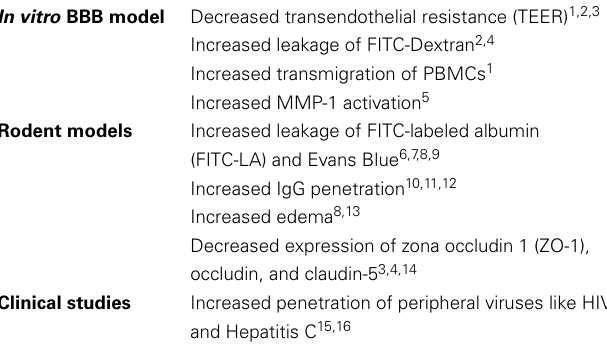
Table 1 | Summary of the preclinical and clinical literature on meth-induced BBB